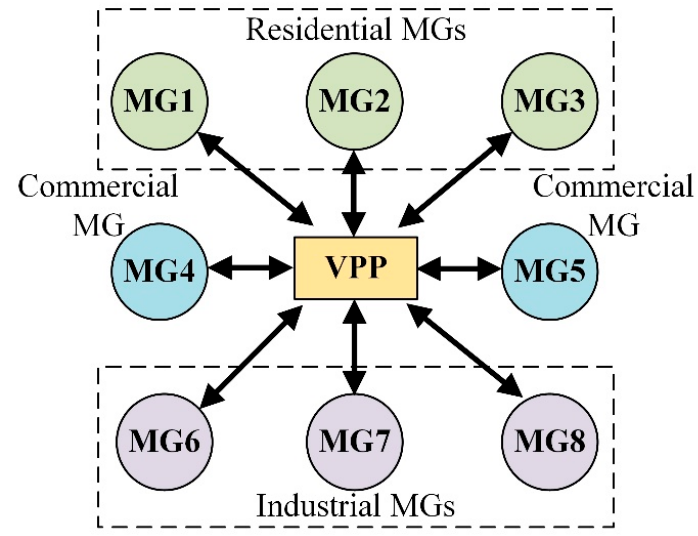
Figure 1. Star-Connected Configuration of NMG. Table 1. Component size of MGs and